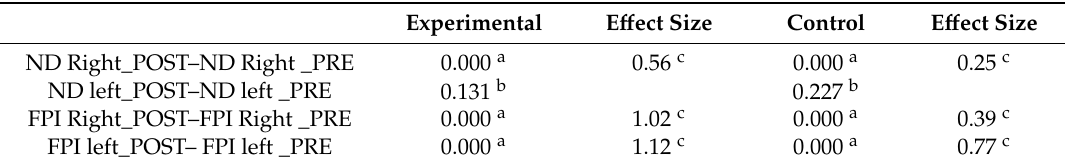
Table 4. Assessment of the FPI and ND within the same study groups. Experimental E ff ect